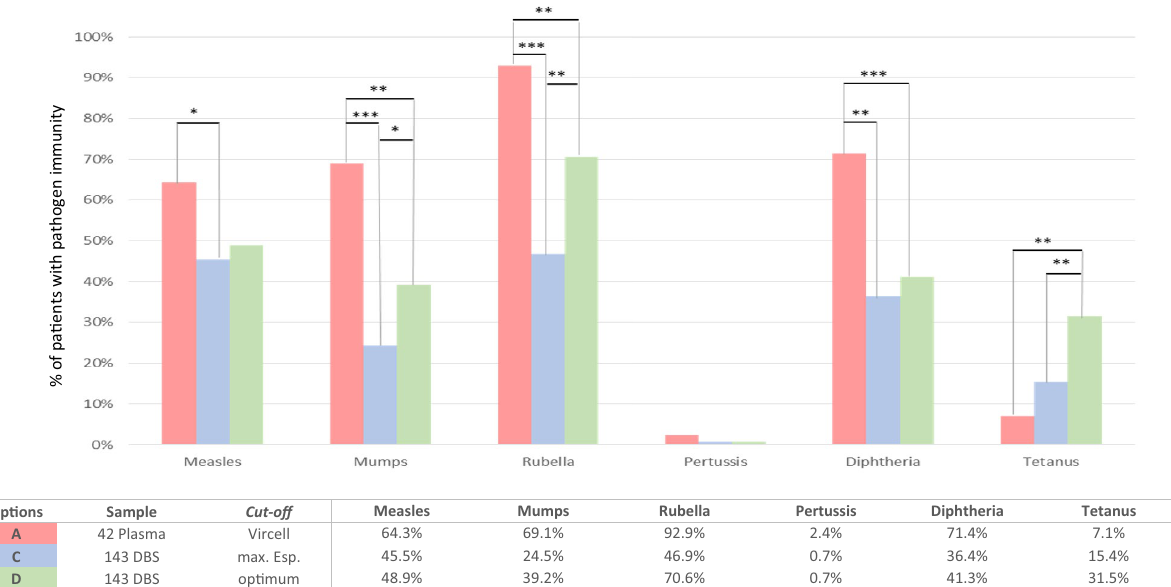
Figure 3. Comparison of the percentage of patients with pathogen immunity in the study population (42 plasmas vs. 143 DBS) using the optimal and maximum specificity cut-offs. The plasma cut-off provided by VIRCELL for each pathogen is shown in Table 1. The optimal or maximum specificity cut-offs calculated for each pathogen are indicated in Table 3. Statistically significant differences found: * p = 0.01–0.03; ** p = 0.001– 0.003; *** p < 0.0001.